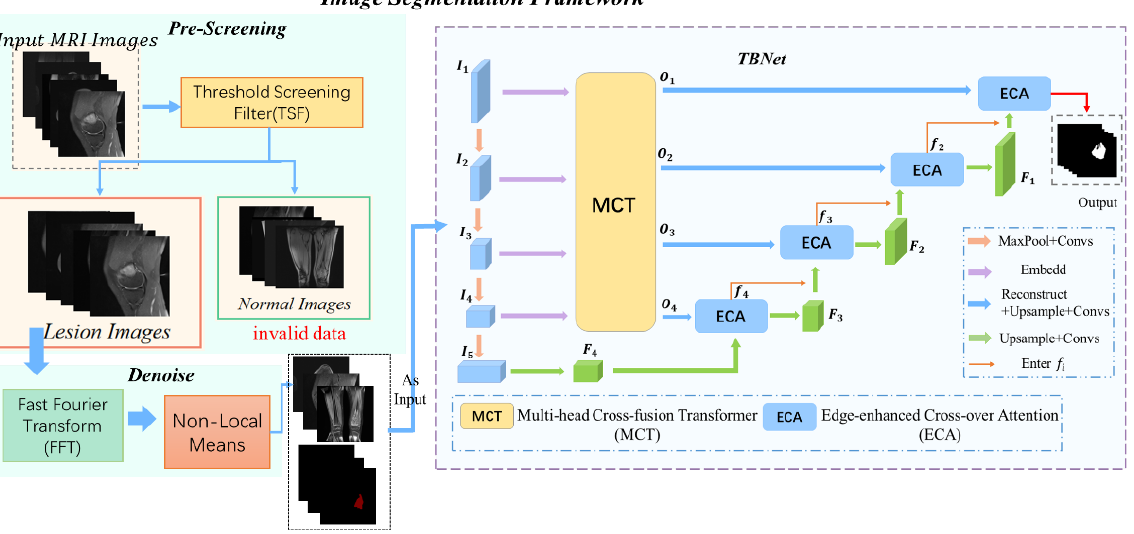
Figure 1. Image Segmentation Framework.